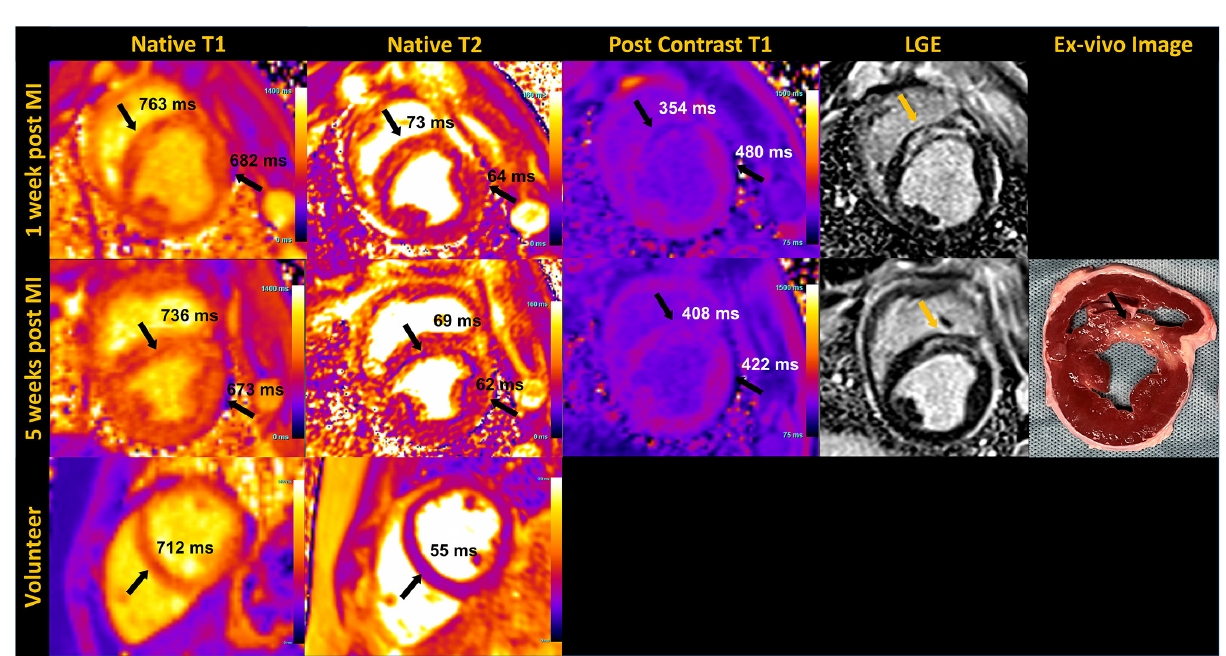
FIGURE6 Mid short-axis quantitative myocardial native T1, T2 map, post contrast T1 map and phase sensitive inversion recovery late gadolinium enhanced (LGE) images in an animal at 1 week and 5 weeks post-myocardial infarction (MI) are shown in the top two rows . The arrows pointing to the septum on T1 and T2 maps indicate elevated native T1 and T2, and reduced post-contrast T1 corresponding to infarct location, confirmed by LGE and the unstained ex-vivo image. T1 and T2 values of the remote myocardium in the lateral region are also indicated. Sub-endocardial rim artifact are seen on the maps due to the animal’s high heart rate. The bottom row shows native T1 and T2 maps acquired in a healthy volunteer in the mid-short axis view.